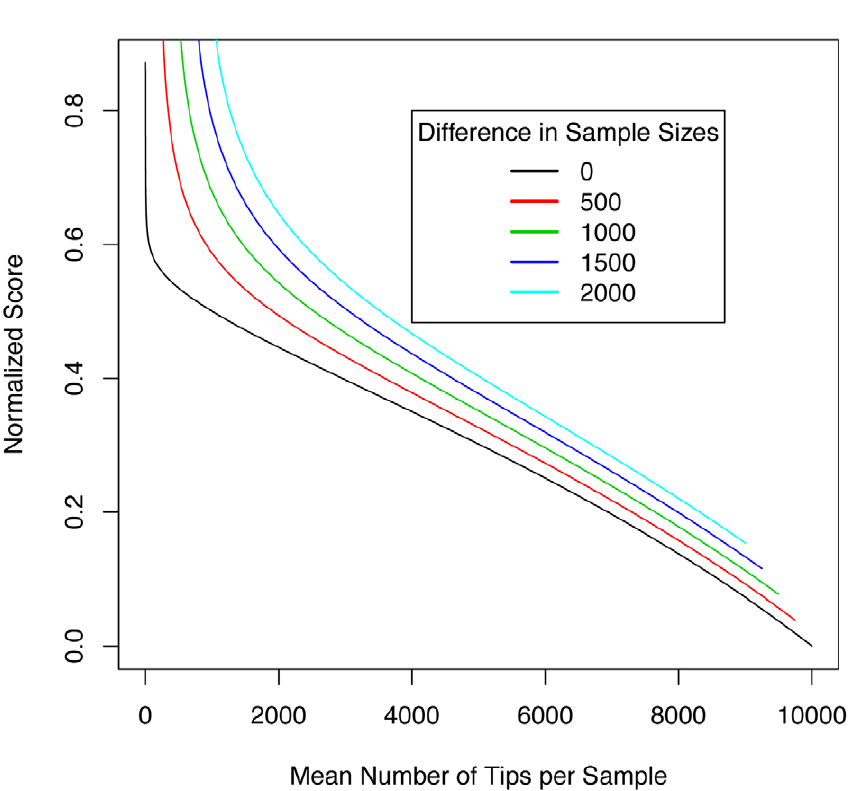
Figure 5. Unifrac score normalized for different sample sizes, for two random samples taken from the same theoretical metacommunity. The score is calculated in terms of expected shared branch length and expected total branch length for the two samples. The black line is for samples of the same size, and colored lines are for various differences in sample size, D N . As D N becomes a larger fraction of mean sample size, there is an increasing deviation from the expectation value for equal samples sizes, indicating that an appropriate normalization accounting for differing sample sizes is potentially crucial in computing phylogenetic beta diversity for differently-sized samples. two different definitions of the metacommunity: (1) all sampled